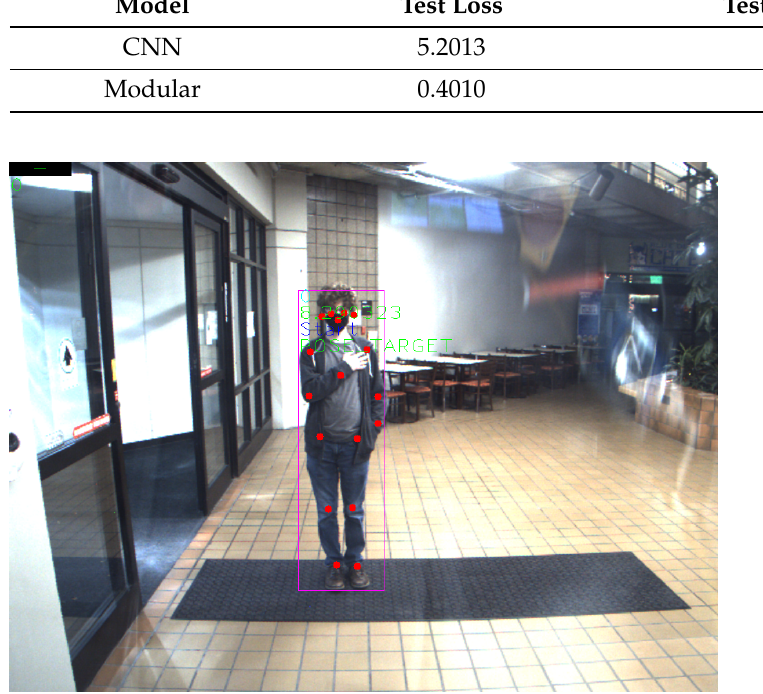
Figure 8. Our modular system performing gesture recognition on author M. Kocherovsky. YOLO determines the location of the author in the frame, which generates the pink bounding box surround- ing him. The posenet component determines the location of the main joints and other key features on the author’s body, which are displayed as red squares. Finally, the gesture recognition module has correctly identified the author’s gesture as follow , and has marked him as the Pose Target , meaning that the vehicle will follow his